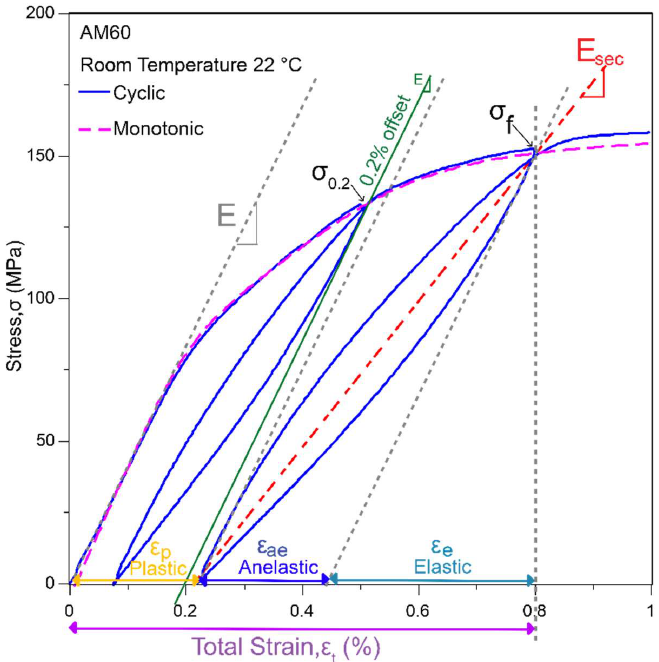
Figure 2. Cyclic tension loading-unloading test of die-cast AM60 at RT. The total strain (ε t ) is made up of linear elastic strain (ε e ), anelastic strain (ε ae ), and plastic strain (ε p ). E is the elastic modulus, while E sec is the secant elastic modulus. σ f is the applied stress at the start of unloading, and σ 0.2 is the 0.2% offset yield stress.